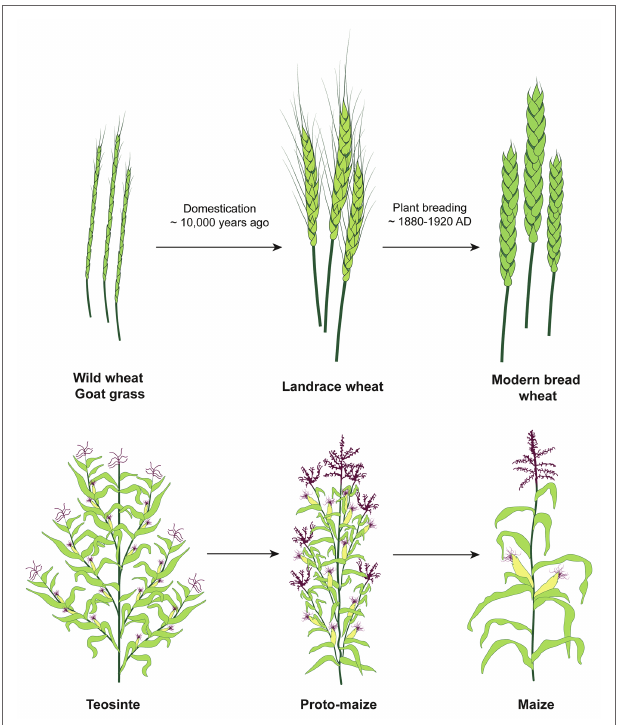
FIGURE 1 | The schematic overview of the stages of wheat and maize domestication and improvement. In the course of domestication, ancient farmers developed landraces using wild populations. The improvement is an ongoing cyclical process by today’s breeders who identify desirable characteristics and develop strategies to combine the beneficial traits to obtain better varieties. The diversity of characteristics, such as biotic and abiotic stresses tolerance, is much higher in the wild compared to the modern varieties due to genetic bottlenecks associated with domestication.